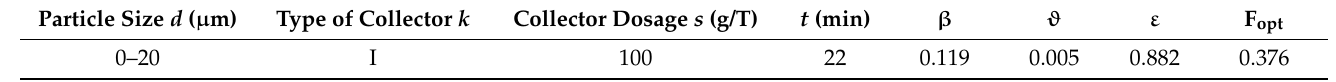
Table 10. The optimal values by values of adjustable variables presented in Table 2.